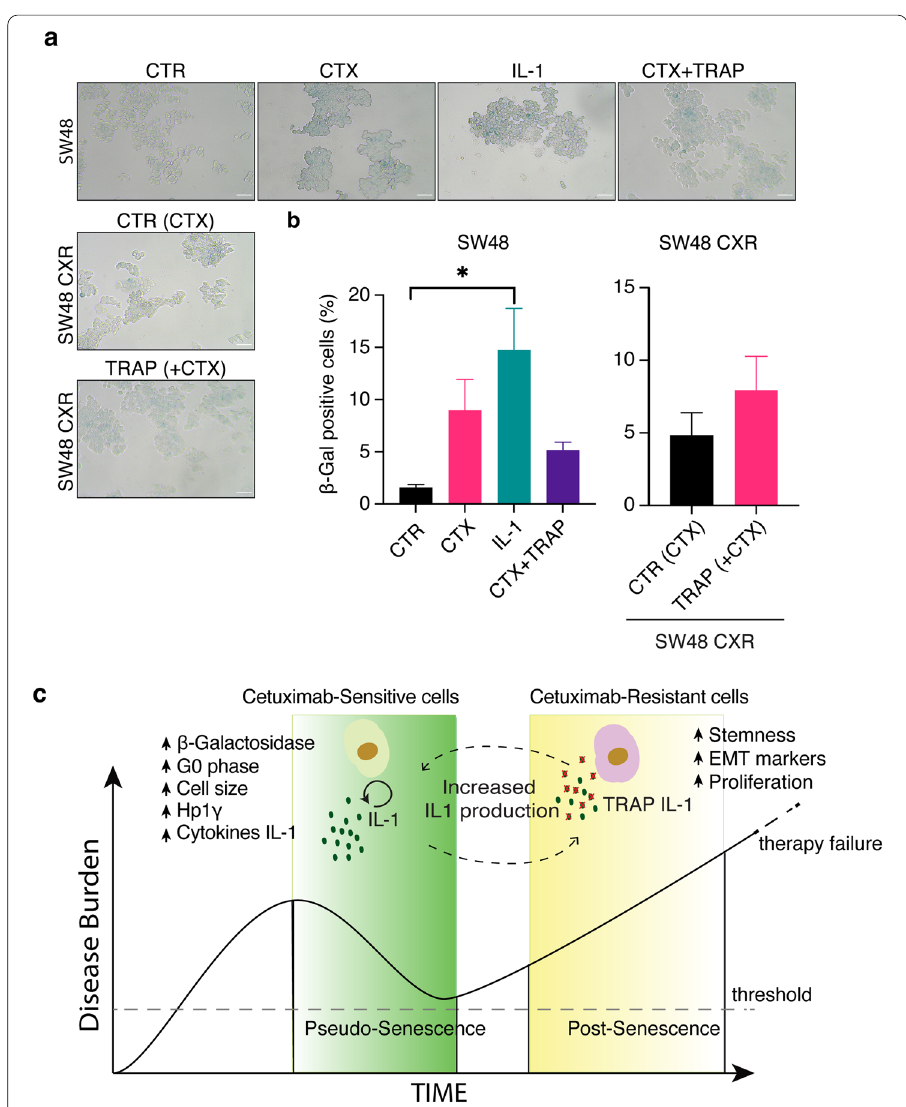
Fig. 5 TRAP IL-1 blocks CTX-induced β-galactosidase activity in SW48 while increasing it in SW48 CXR. SW48 and SW48 CXR cells were seeded in 12-well plates in 10% of FBS medium and treated the following day with CTX (50 μg/ml), IL-1 (α β 10 ng/ml each), and TRAP (20 μg/ml). After 4 days, cells were washed, fixed, + and stained with β-galactosidase for 5 h at 37 °C. Photos were taken at 20 magnification (Leica). Scale bar, × 50 μm ( a ). The histograms show analysis of positively stained cells (mean SEM) for SW48 and SW48 CXR, ± respectively ( b ). Statistical analysis was carried out using one-way ANOVA with Tukey’s multiple comparison test. ( c) The model depicted in the cartoon describes how, in the CTX-sensitive phase, IL-1 induces pseudo-senescence and growth-arrest, but in resistant cells, IL-1 pushes cells into a post-senescence